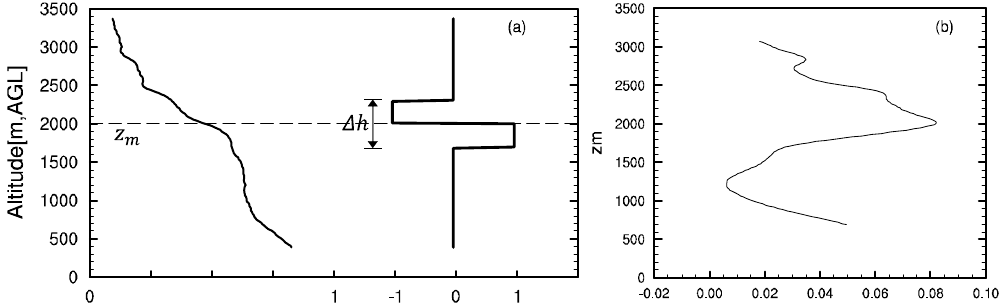
( b ) the resulted covariance transform, w f as ∆ h =